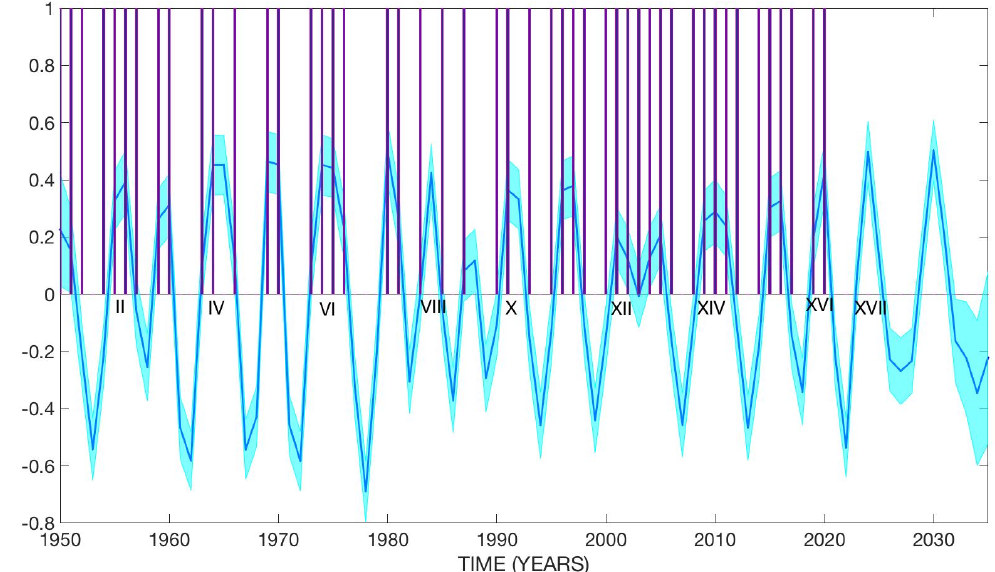
Figure 6. Probabilistic hindcasts and forecasts for the category 3 Atlantic hurricanes. Bayesian inference of the LS-SVM model (blue line and shade) compared with the historical category 3 Atlantic hurricanes (purple vertical bars) clustered in 16 groups (I–XVI). In addition, the probabilistic earth- quake prediction is shown for the following period (cluster XVII). The blue shaded area represents the 95% confidence intervals of the Bayesian